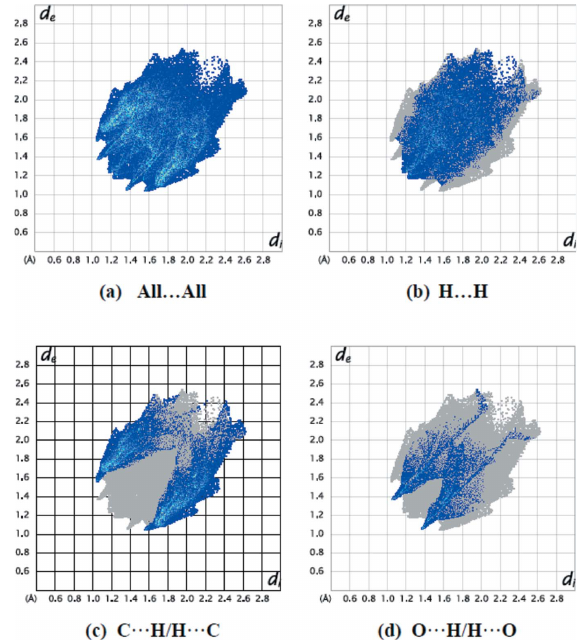
Figure 5 Two-dimensional fingerprint plots of the title compound, showing ( a ) all interactions, and delineated into ( b ) H (cid:2)(cid:2)(cid:2) H, ( c ) C (cid:2)(cid:2)(cid:2) H/H (cid:2)(cid:2)(cid:2) C and ( d ) O (cid:2)(cid:2)(cid:2) H/H (cid:2)(cid:2)(cid:2) O interactions. [ d e and d i represent the distances from a point on the Hirshfeld surface to the nearest atoms outside (external) and inside (internal) the surface,